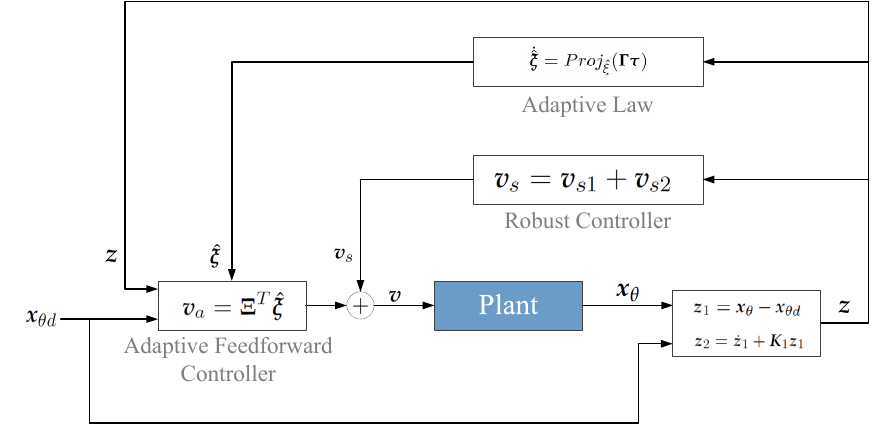
Figure 3. Control block diagram of the proposed